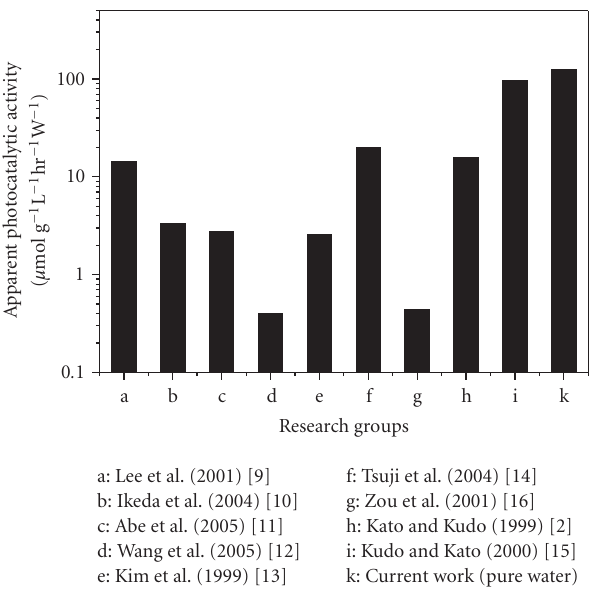
Figure 13: Comparison of apparent photocatalytic activity of current work with that of published